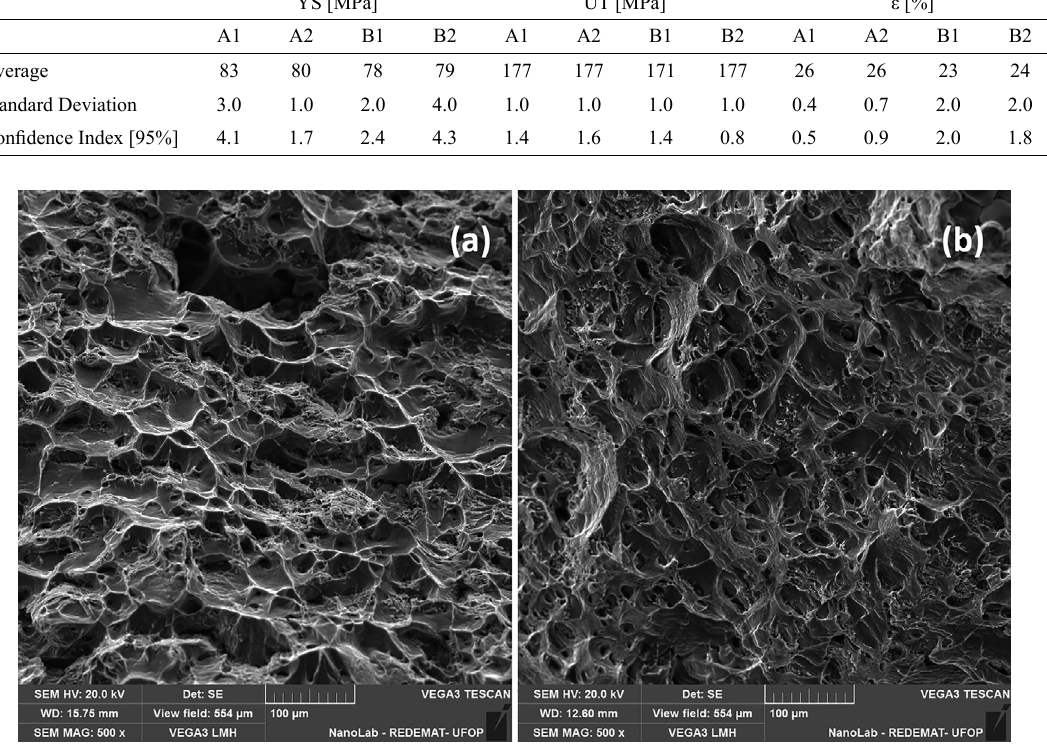
Figure 8. SEM fractographs of tested specimens (a) A1 condition (reference), (b) B2 condition (new proposition)